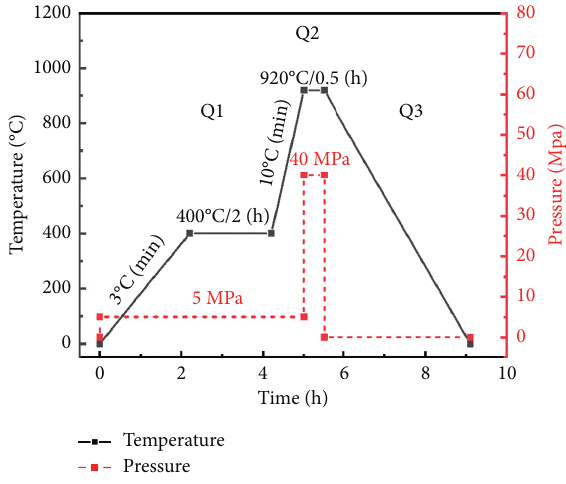
Figure 2: Hot-pressing curves of the composite.